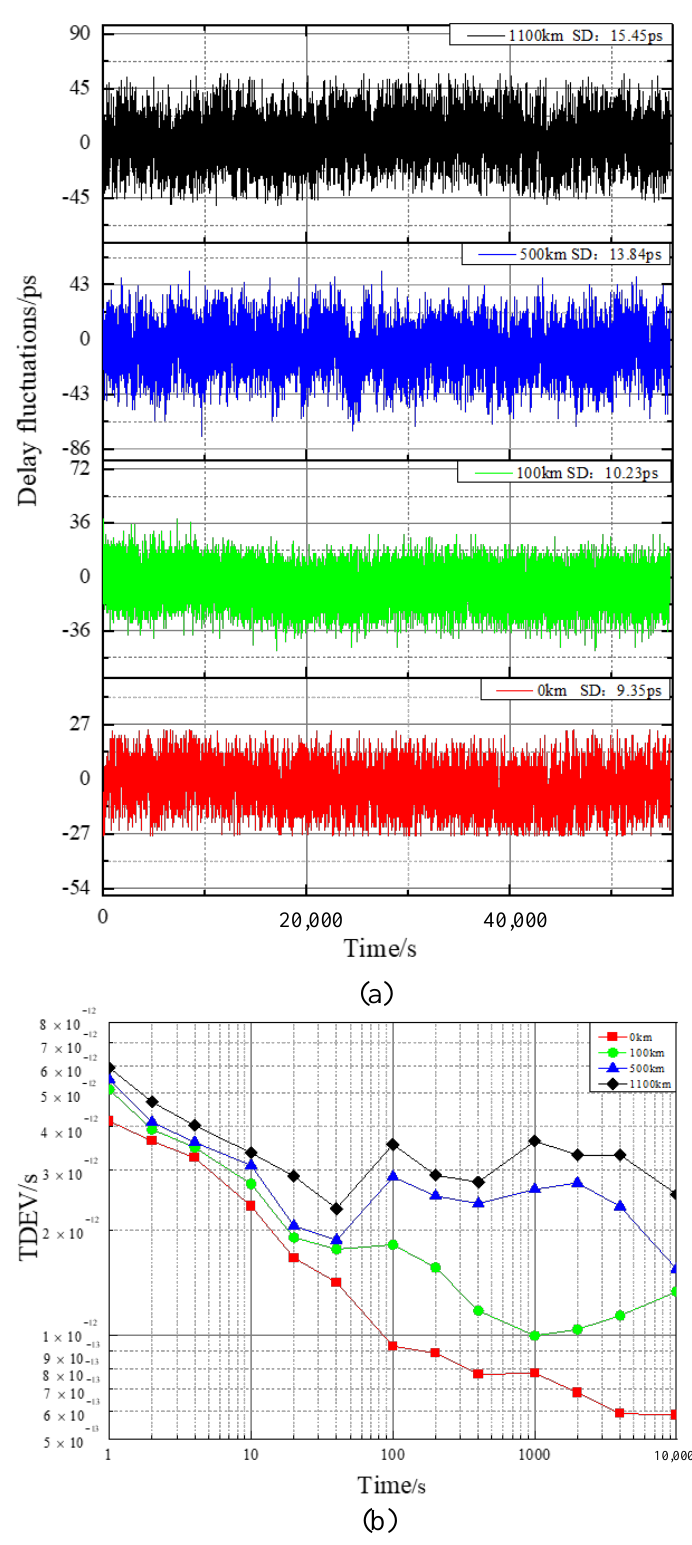
Figure 7. ( a ) Instability of the propagation delay of the optical fiber link with a length of 0–1100 km. ( b ) TDEV results of the 1-PPS time transfer for different length laboratory-tested links with the propagation delay